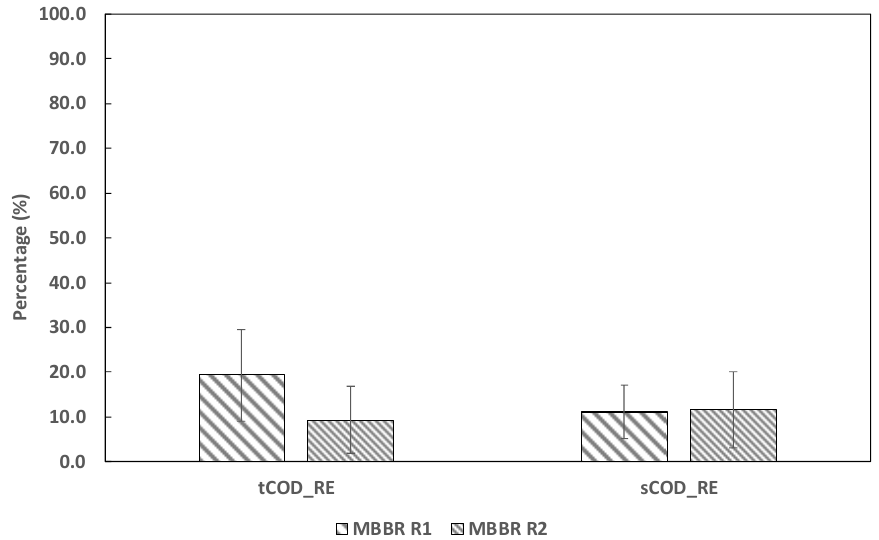
Figure 4. The total and soluble removal efficiency (tCOD_RE and sCOD_RE) in MBBR R1 and MBBR R2 reactors ( n = 23).